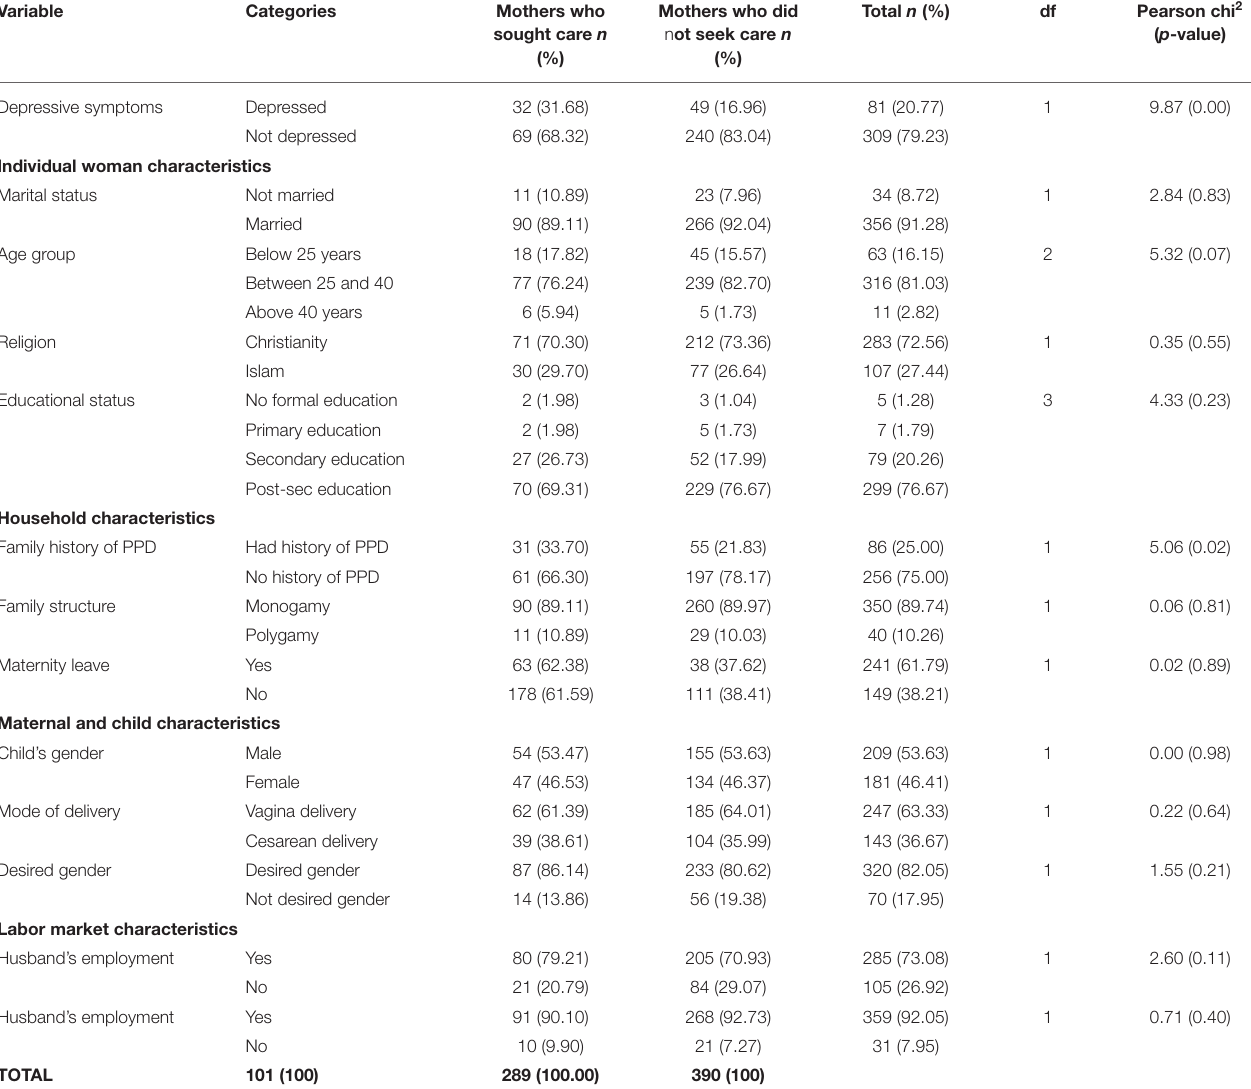
TABLE 2 | Descriptive characteristics of categorical